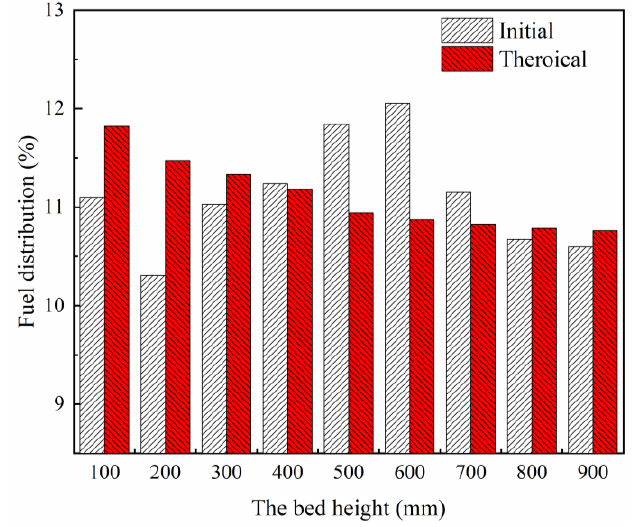
Figure 6. The initial fuel distribution in the material layer and the theoretical values.